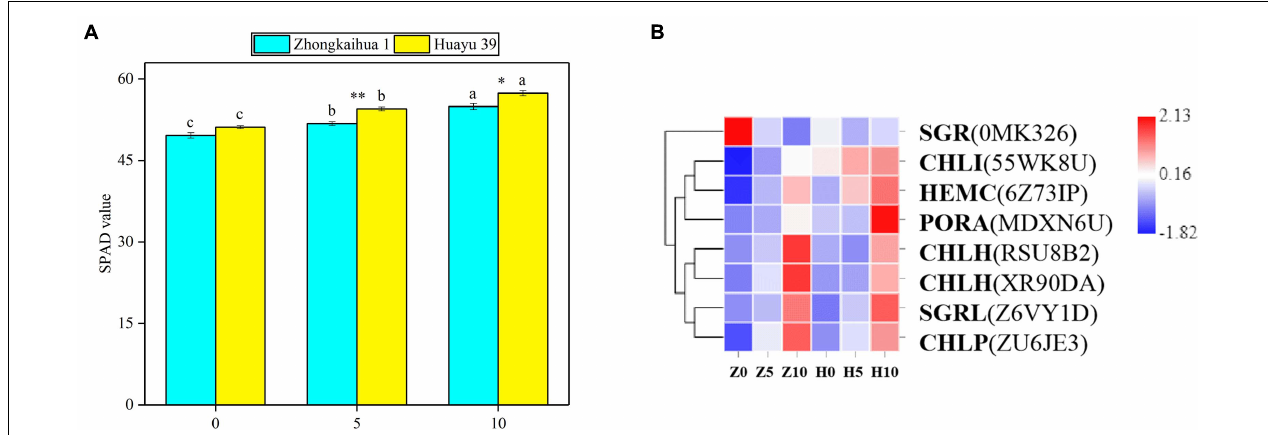
FIGURE 5 | Effects of waterlogging on porphyrin and chlorophyll metabolism. (A) Effects of waterlogging stress on the soil and plant analysis development (SPAD) value of peanut at the flowering stage. Data represent the mean ± standard error. The measurement was conducted on the leaves of the main stem after treatment. Letters a and b after the value represent statistically significant differences ( p < 0.05) within a variety under different waterlogging treatments as determined by the least significant difference test. Significant differences at * p < 0.05 and ** p < 0.01 between Zhongkaihua 1 (ZKH 1) and Huayu 39 (HY 39) under the same treatment. 0, 5, and 10 represent without waterlogging, waterlogging for 5 days, and waterlogging for 10 days, respectively. (B) Expression patterns of the differentially expressed genes (DEGs) induced by waterlogging stress in the porphyrin and chlorophyll metabolism pathway. Expression change of the DEGs with at least twofold changes and p < 0.05 in the porphyrin and chlorophyll metabolism pathway. The expression levels were calculated in fragment per kilobase per million reads (FPKM) from triplicate experiments. Heat map shows the normalized value Z-score after log2(FPKM) transformation. The color in the heat map represents the Z-score after the transformation of log2(mean FPKM). Each row in the heat map represents the levels of a DEG under different conditions. The DEG name and the gene ID in parenthesis were listed on the right side of the heat map. Abbreviations for DEGs encoding proteins: SGR, senescence-inducible chloroplast stay-green protein 2 [Glycine max]; CHLI, magnesium chelatase i2; HEMC, porphobilinogen deaminase; PORA, protochlorophyllide oxidoreductase A; CHLH, magnesium chelatase subunit [Glycine max]; SGRL, senescence-inducible chloroplast stay-green protein 2 [Glycine max]; CHLP, geranylgeranyl diphosphate reductase, chloroplastic [Glycine